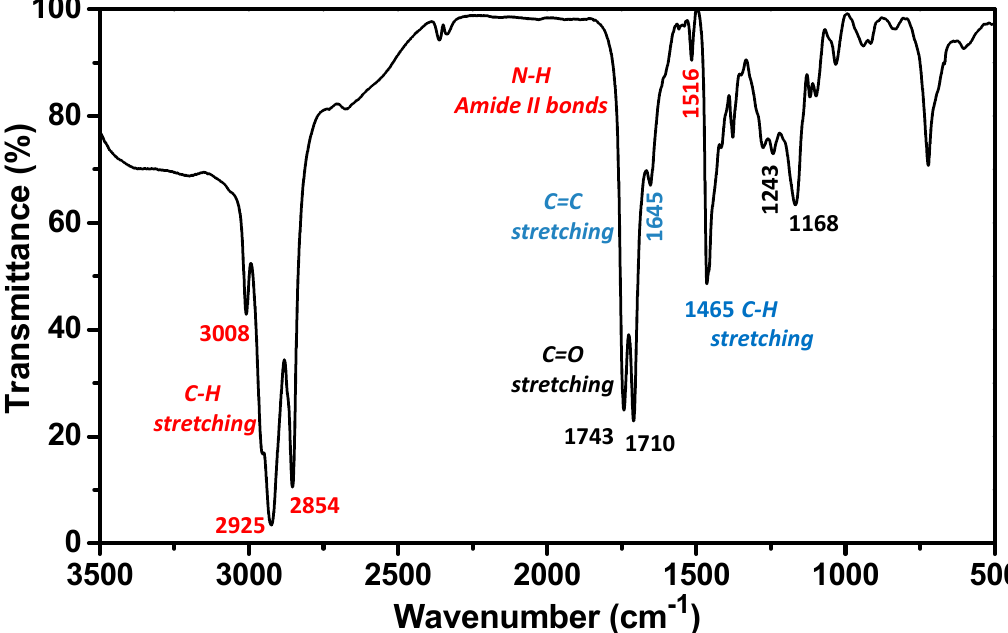
Figure 1. Fourier Transform infrared spectroscopy (FTIR) spectrum of the lipopeptide biosurfactant extracted from corn steep liquor. The color code indicates the assignment of the different bands.